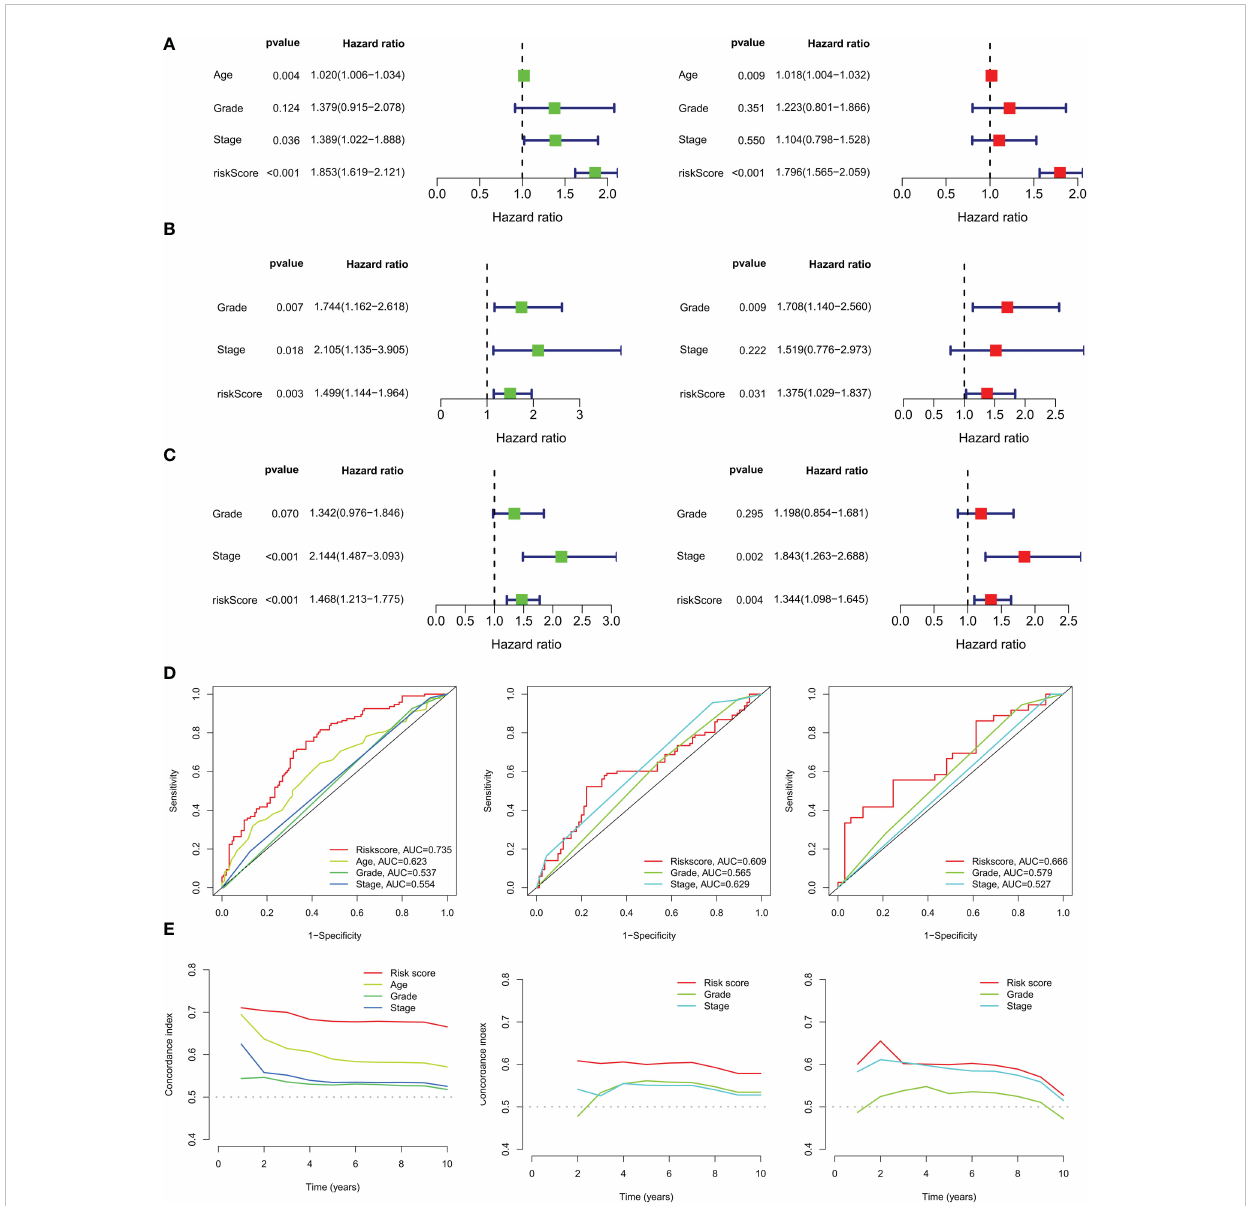
FIGURE 6 Independent prognostic analysis of ovarian cancer risk scores and clinicopathological factors. (A) Univariate and multivariate Cox regression analyses of clinicopathological variables and risk scores in the TCGA training cohort, (B) GSE63885 and (C) GSE9891 validation cohorts. (D) AUC values for risk scores and clinical characteristics of TCGA-OV, GSE63885, and GSE9891 at 3 years. (E) Coherence index (C-index) for the TCGA-OV, GSE63885, and GSE9891